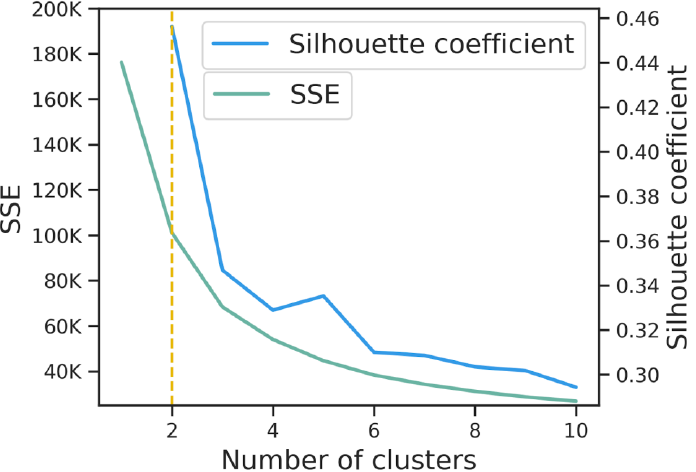
Figure A2. Evaluation of K-means clustering algorithm and selection of optimum numbers of clusters used for waterlogging mapping. The evaluation was based on silhouette coefficients and the sum of the squared Euclidean distances of each point to its closest centroid. The orange dashed line indicates the optimum number of clusters (i.e., two) selected for waterlogging detection. The number is selected based on the highest value of the silhouette and elbow joint point in the SSE line. Note the SSE values are in thousands, hence the letter